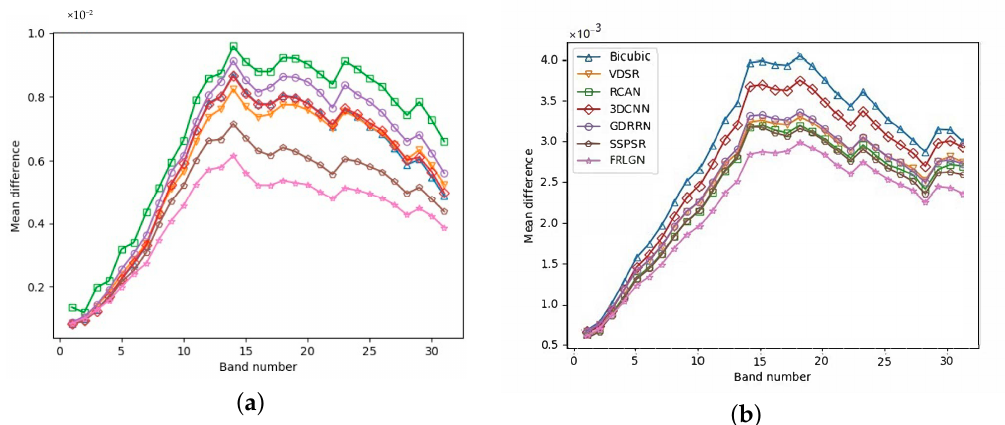
Figure 9. Mean spectral difference curve of two hyperspectral images ( a , b ) from the Harvard testing dataset with the scale factor 4.